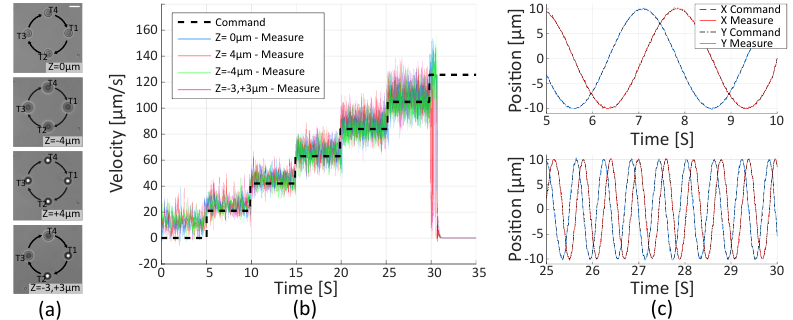
Figure 6. Teleoperated rotation in velocity mode of four micro-beads at different Z positions. ( a ) Pictures of four trapped beads in different axial configurations. Scale bar is 5 µm long. ( b ) Velocity reference and measured velocity in 4 different configurations. ( c ) X and Y positions of the Trap 1 in “Z = 0 µm” configuration at a speed of 21 µm/s and 105 µm/s. The maximal reachable velocity without losing the traps is 105 µm/s with an error of